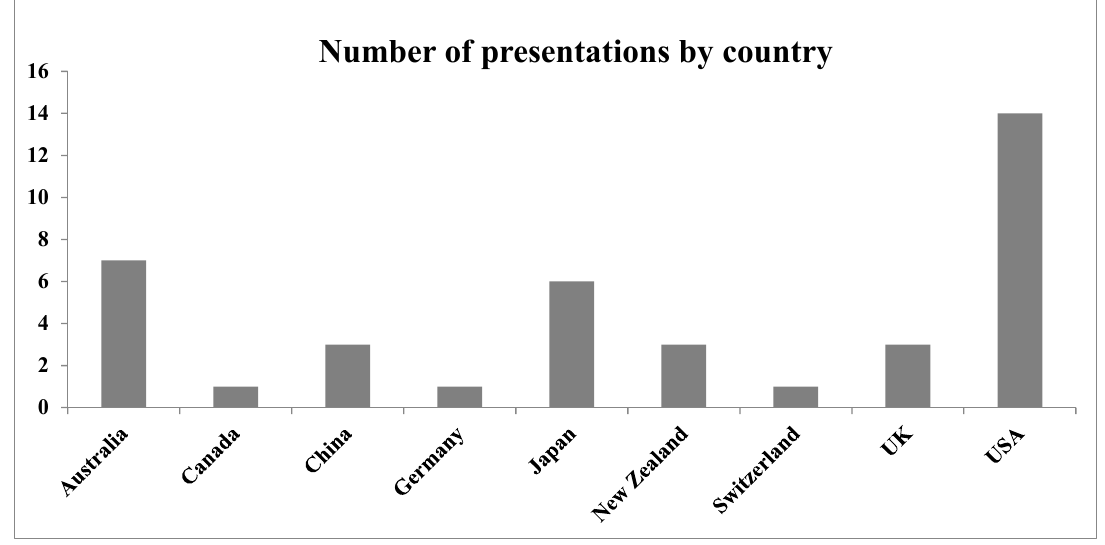
Figure 1. Number of presentations at the Pacifichem 2015 FBLD symposium arranged alphabetically by country.